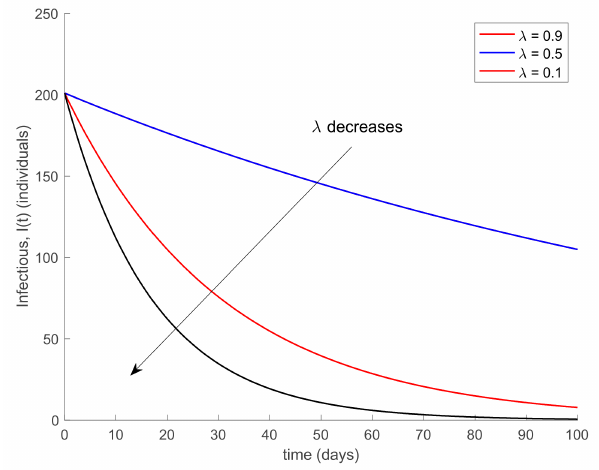
Figure 4. Evolution of the infectious subpopulation for different values of λ and β given by Equation (30).